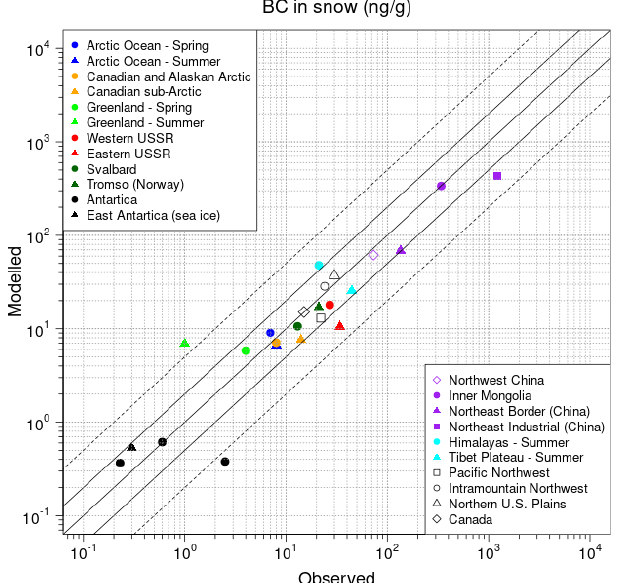
Figure 2. Same as Fig. 1 but for black carbon equivalent (BCE). BCE is defined in Eq. (2) and represents the RAA-snow mass scaled with the MAC of each